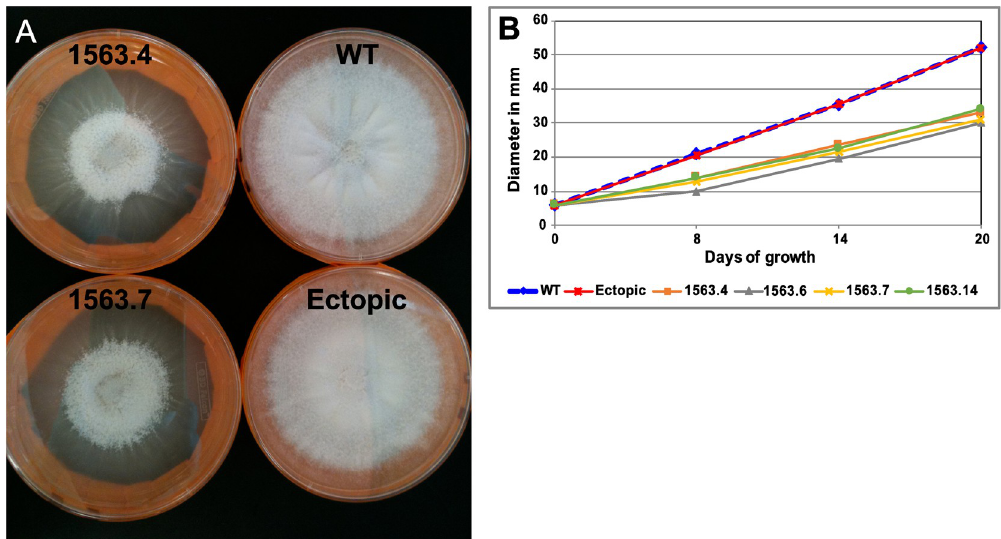
Fig 1. Growth morphology of Δ ryp1 mutants. (A) C . posadasii Δ ryp1 strains (1563.4 and 1563.7) exhibit a growth-limiting phenotype, in comparison to WT and an ectopic transformant. (B) Plugs of 6 mm were transferred from freshly growing plates to 2X GYE plates and incubated at room temperature, to measure colony radial growth. Colony diameters were measured on days 8, 14 and 20. Four independent Δ ryp1 strains (1563.4, 1563.6, 1563.7 and 1563.14), as well as the WT parental strain and an ectopic transformed strain (1563.1) were tested.